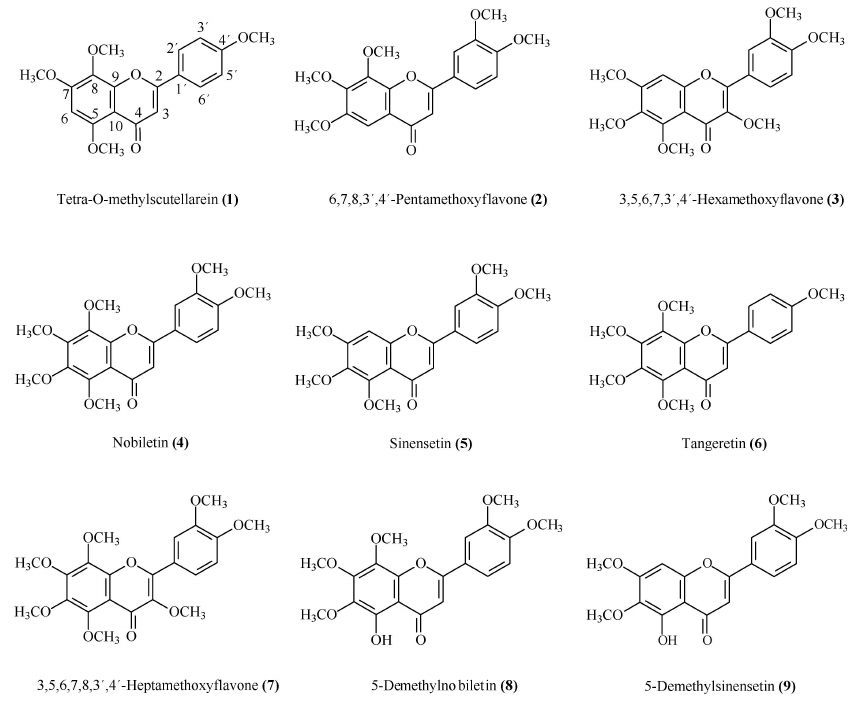
Figure 1. Structures of the flavonoids 1 – 9 isolated from citrus waste of Citrus sinensis